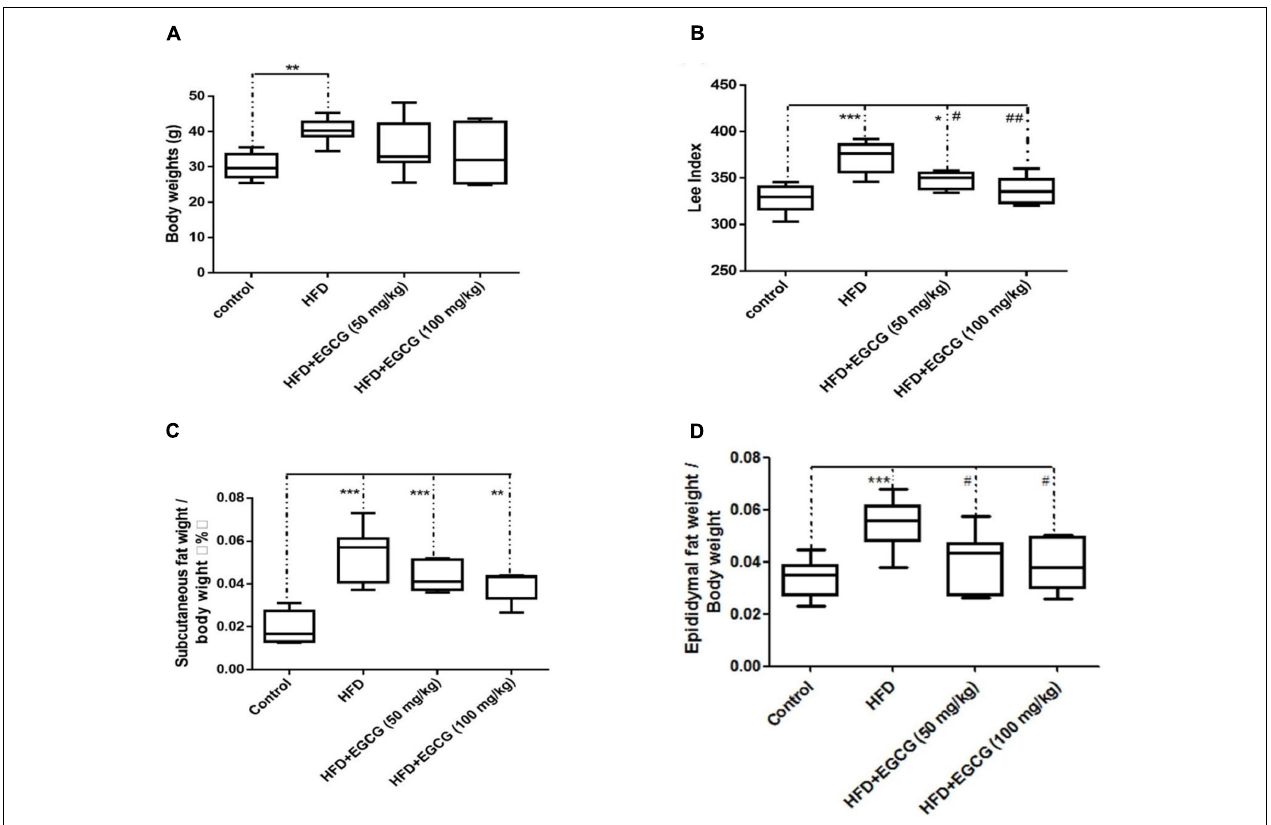
FIGURE 1 | EGCG reduced obesity and the adipose weight in mice. (A) The body weights of mice after 20 weeks feeding; (B) Lee index; (C) ratio of subcutaneous fat weight to body weight; and (D) epididymal fat weight to body weight. Data were shown as mean ± SEM ( n = 6/7 each group). ∗ P < 0.05; ∗∗ P <